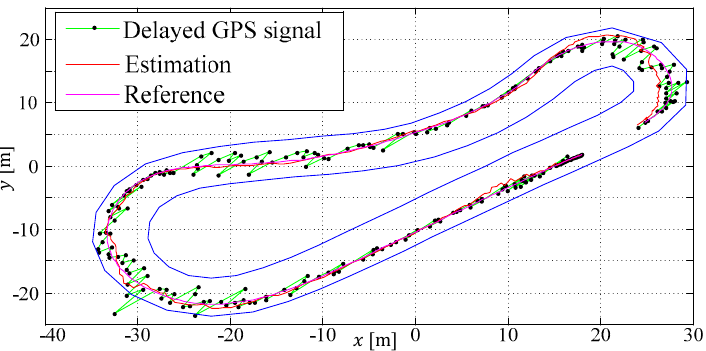
Figure 19. ESTM MHE single shooting (SS) up ( n d = 3): x–y position estimations results.